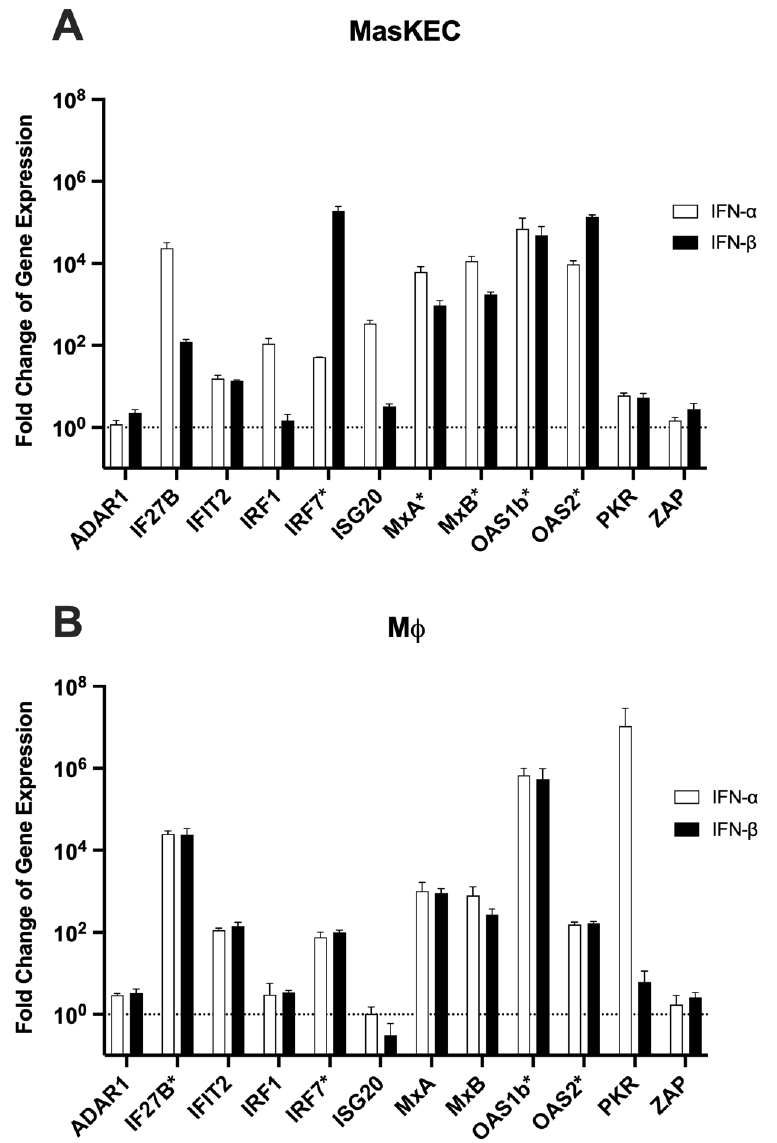
Figure 1. Changes in ISG expression after stimulation with IFN- α or IFN- β . MasKECs ( A ) or M Φ s ( B ) were stimulated for 16 h with 500 U/mL IFN- α (clear bars) or IFN- β (black bars). Cells without stimulation were used for later normalisation. Cellular RNA was harvested, depleted of DNA, and used for RT-PCR analysis of ISG expression levels. For the RT-PCR-based assays, 10 ng of overall extracted RNA was used. Normalisation was performed with the ΔΔ Ct method with the housekeeping gene Ppil4. Genes were marked with an asterisk (*) if no signal Ct value for the controls was obtained due to too low concentrations in unstimulated cells. The previously determined cut-off Ct values (Table 2) were used to calculate the fold change of ISG expression of these genes. The dashed line indicates the ISG level of untreated control cells. The experiment was performed in triplicate. Shown are the mean and standard deviation.